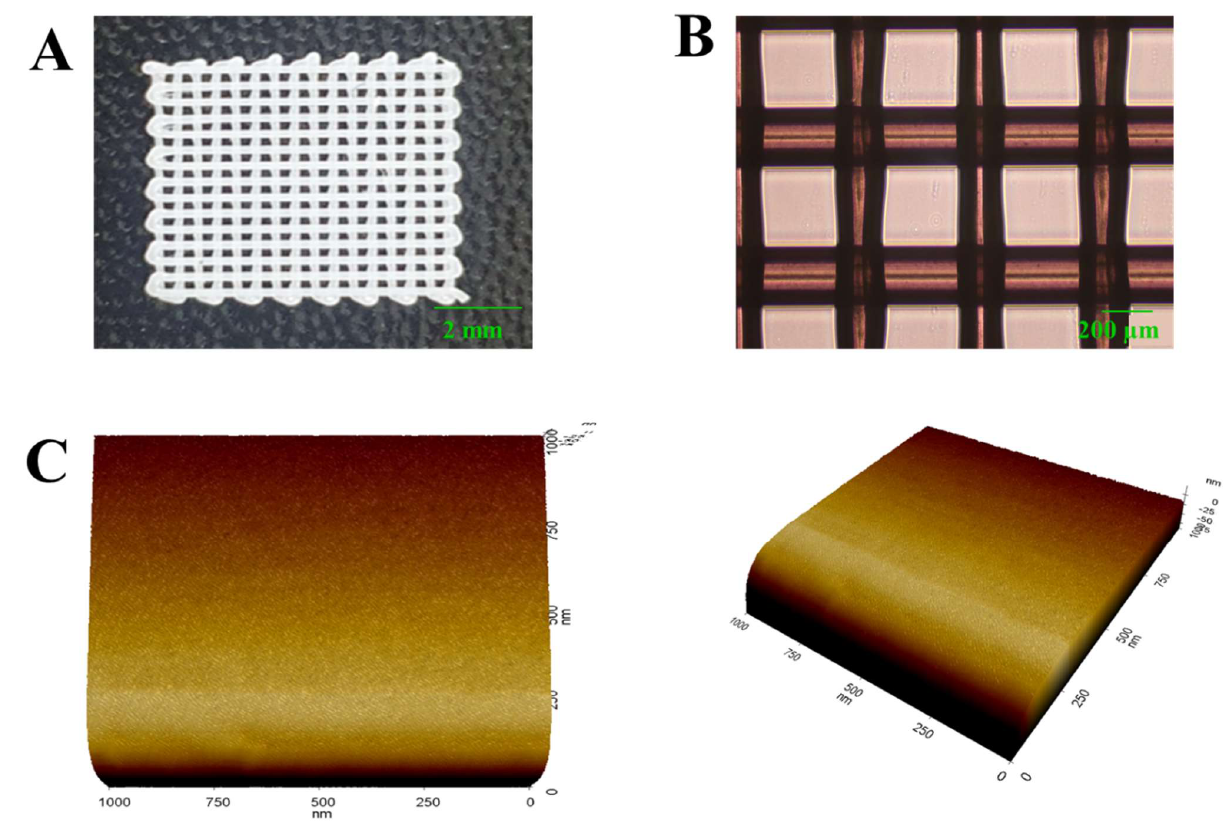
Figure 2. Physical characteristics of the IPTS with 40% infill density, as shown by ( A ) a photograph, ( B ) optical image (scale bar: 200 µm), and ( C ) atomic force microscope image (1 µm 3 ) demonstrating the surface roughness of the IPTS.